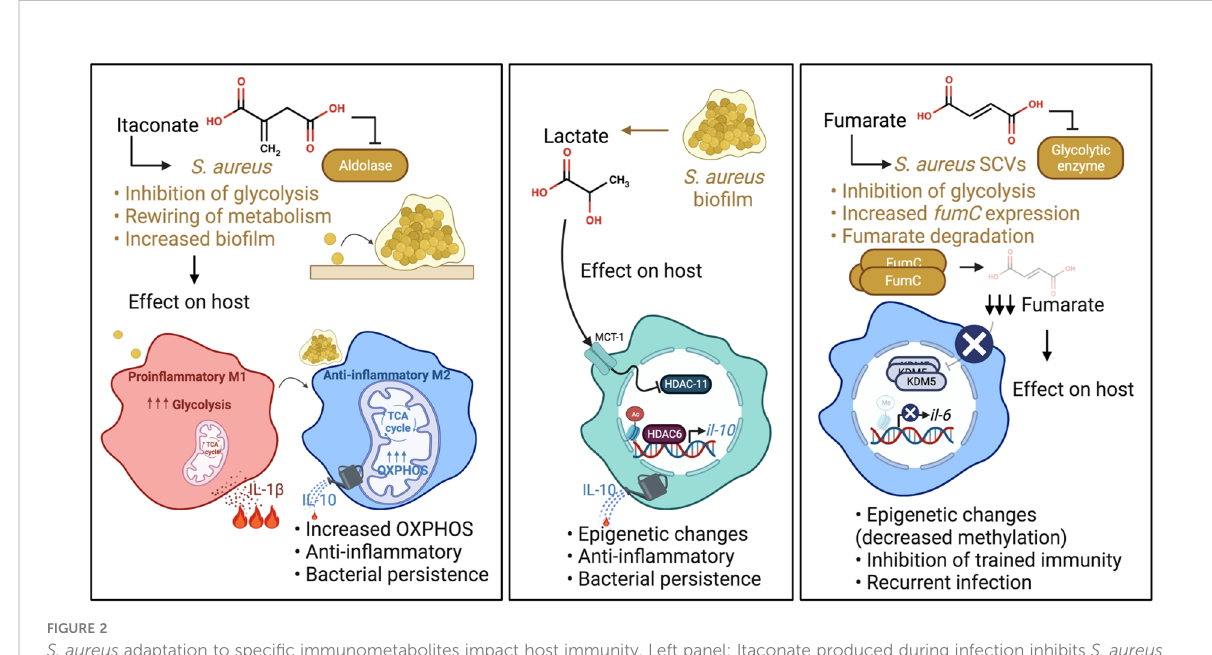
FIGURE 2 S. aureus adaptation to speci fi c immunometabolites impact host immunity. Left panel: Itaconate produced during infection inhibits S. aureus glycolysis. This rewires staphylococcal metabolism, promoting carbon fl ux through metabolic pathways that synthesize bio fi lms. S. aureus bio fi lms promote OXPHOS in macrophages and an anti-in fl ammatory phenotype. Middle panel: Lactate produced by S. aureus bio fi lm inhibits HDAC11 in macrophages and promotes anti-in fl ammatory IL-10 production. Right panel: Fumarate also inhibits glycolysis. In order to relieve the inhibition of glycolysis and ensure their survival, S. aureus SCVs increase their expression of fumC , which encodes the enzyme fumarate hydratase to degrade fumarate. SCV degradation of fumarate inhibits trained immunity through decreased methylation at the promoters of genes encoding proin fl ammatory cytokines such as IL-6. This impairs swift cytokine production upon